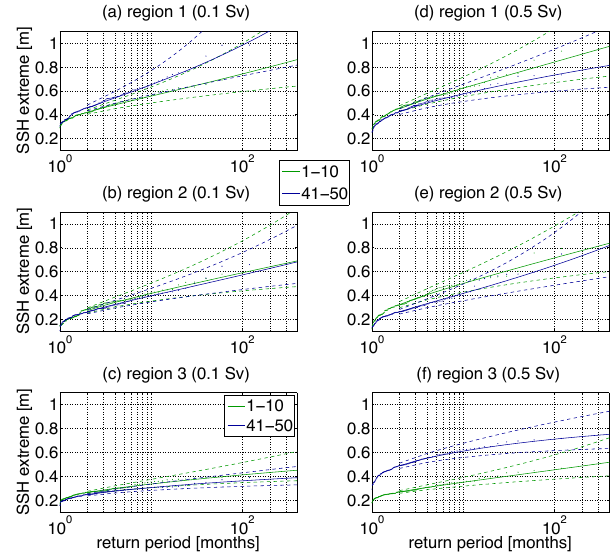
Figure 7. Generalised extreme-value (GEV) distribution fits to monthly maximum SSHP changes in the different regions. Fig. 7. Generalized Extreme Value distribution (GEV) fits to monthly maximum SSHP changes in the different (a–c) GEV plots for the 0.1Sv HR simulation. (d–f) GEV plots regions. (a-c) GEV plots for the 0.1 Sv HR simulation. (d-f) GEV plots for the 0.5 Sv HR simulation. The for the 0.5Sv HR simulation. The extreme values are plotted as a extremevaluesareplottedasafunctionofreturntimesusing10yearsofdataatthebeginningofthesimulation function of return times using 10 years of data at the beginning of (green: years 1-10) and for a similar period at the end of the simulation (blue: 41-50). The dashed curves the simulation (green: years 1–10) and for a similar period at the indicate the 95% confidence interval corresponding to the GEV fit. The long term signal is filter out before end of the simulation (blue: 41–50). The dashed curves indicate the determining the extreme values. 95% confidence interval corresponding to the GEV fit. The long- term signal is filtered out before determining the extreme